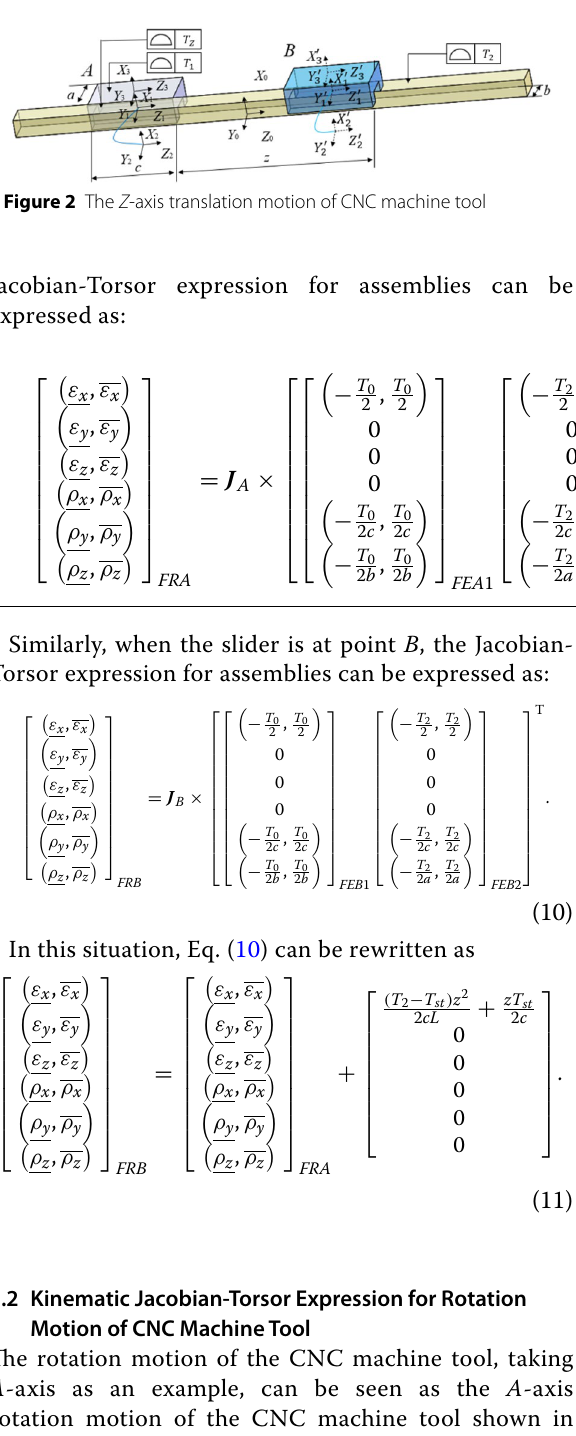
Figure 3. The base and rotary parts of the rotary table are assembled concentrically. And the rotary table can rotate around the center of the base. The bottom surface of each cylinder is defined as the base surface